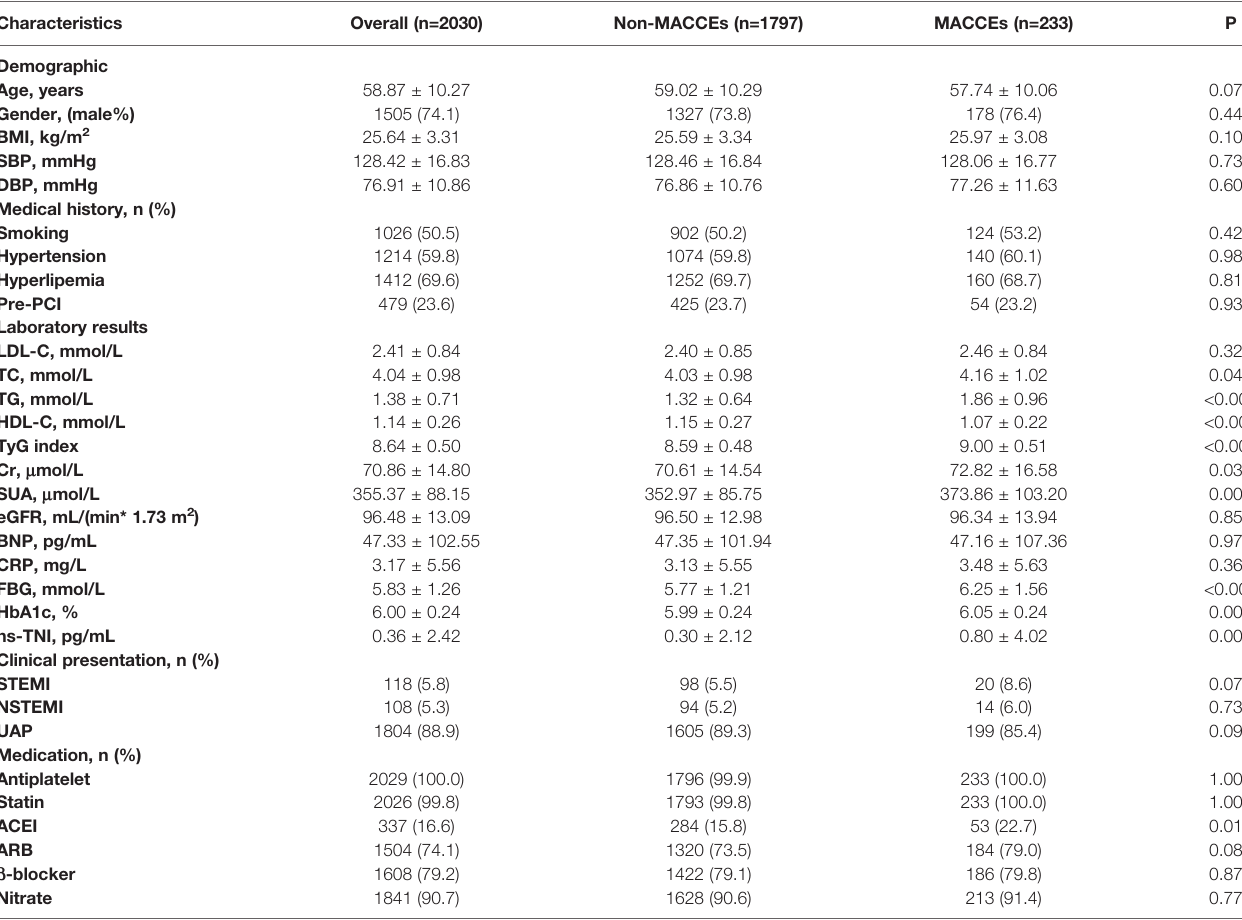
TABLE 1 | Baseline clinical characteristics among the MACCEs and non-MACCEs group of overall population.